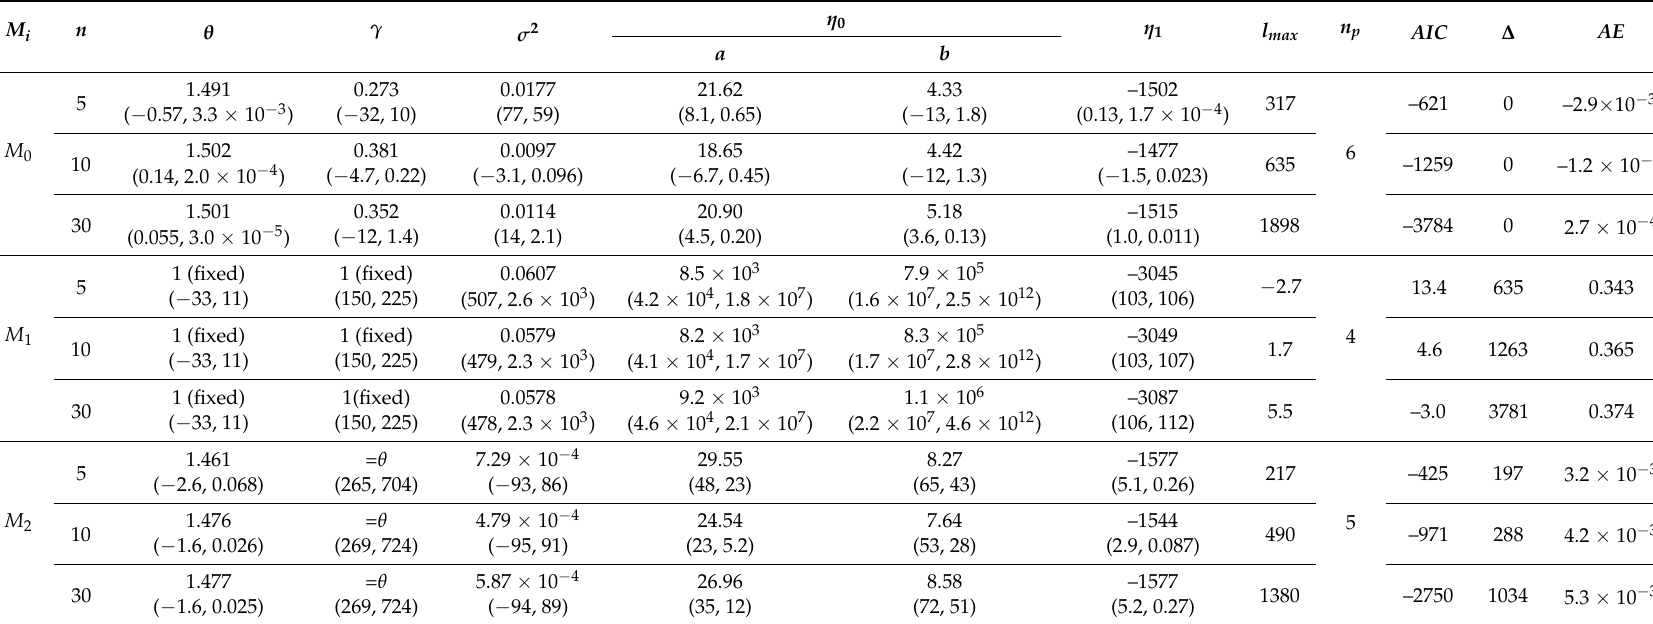
Table 1. Simulation example: parameter estimates with RE s and RSE s in percentage (in parentheses), and AE s of reliability estimation for three candidate models under three sample